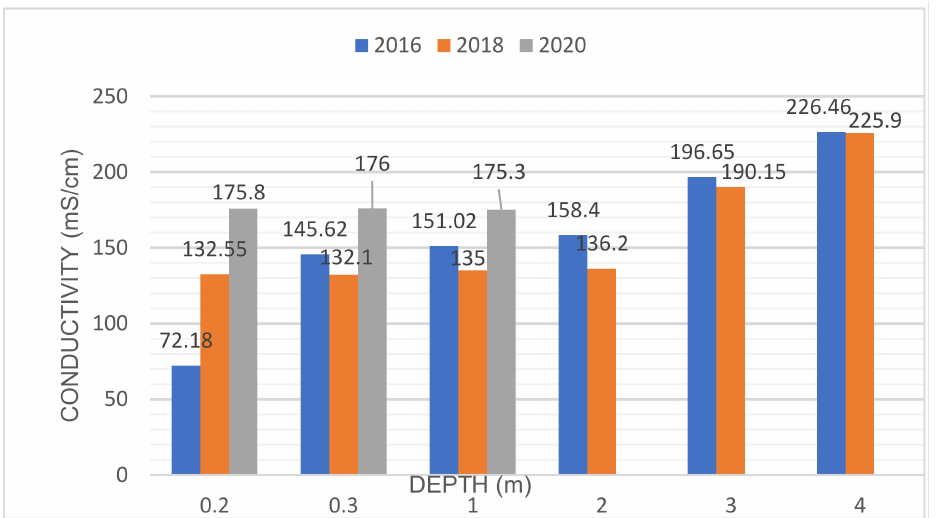
Figure 5. Conductivity levels at several depths of Lake Rotund.